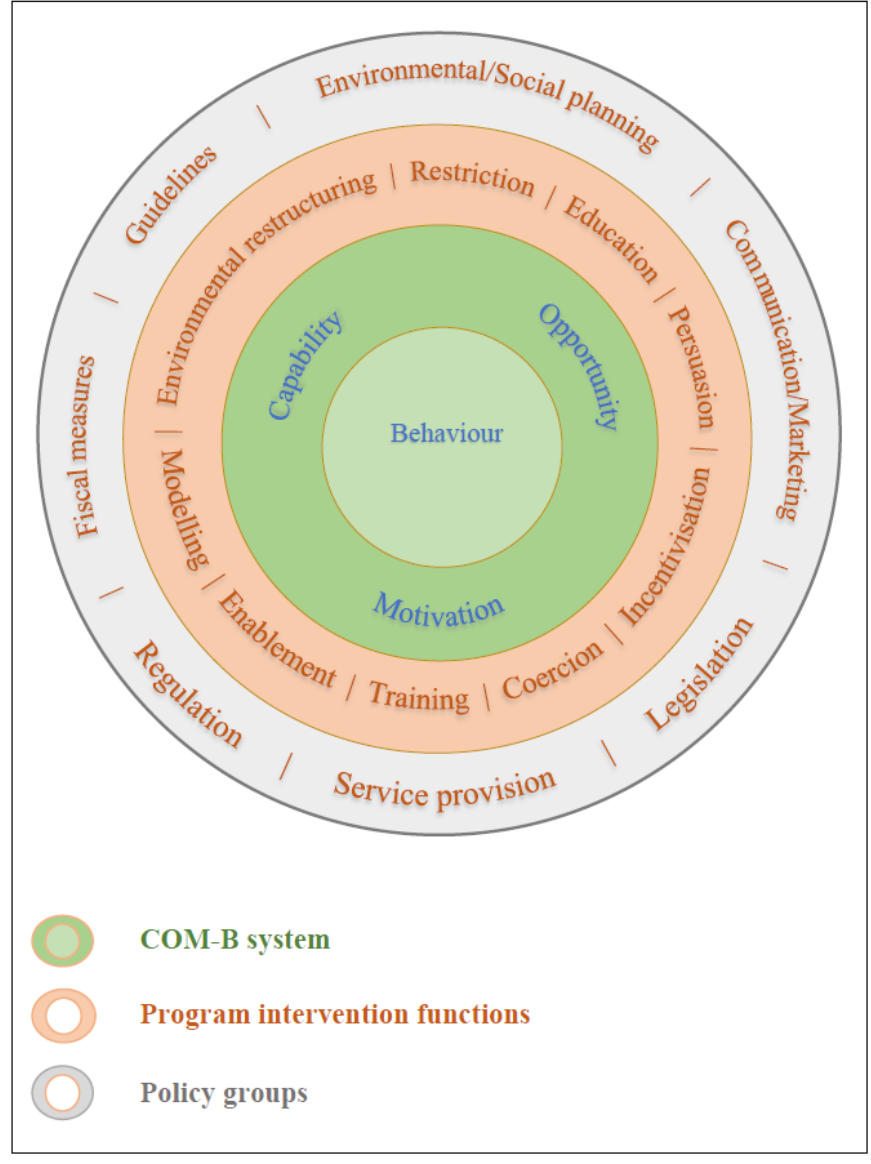
Figure 1. The COM-B System and the BCW Model, adapted from Michie et al. [16]. Definitions of the nine intervention functions are presented in Table 1, together with specific puppy-raising examples.